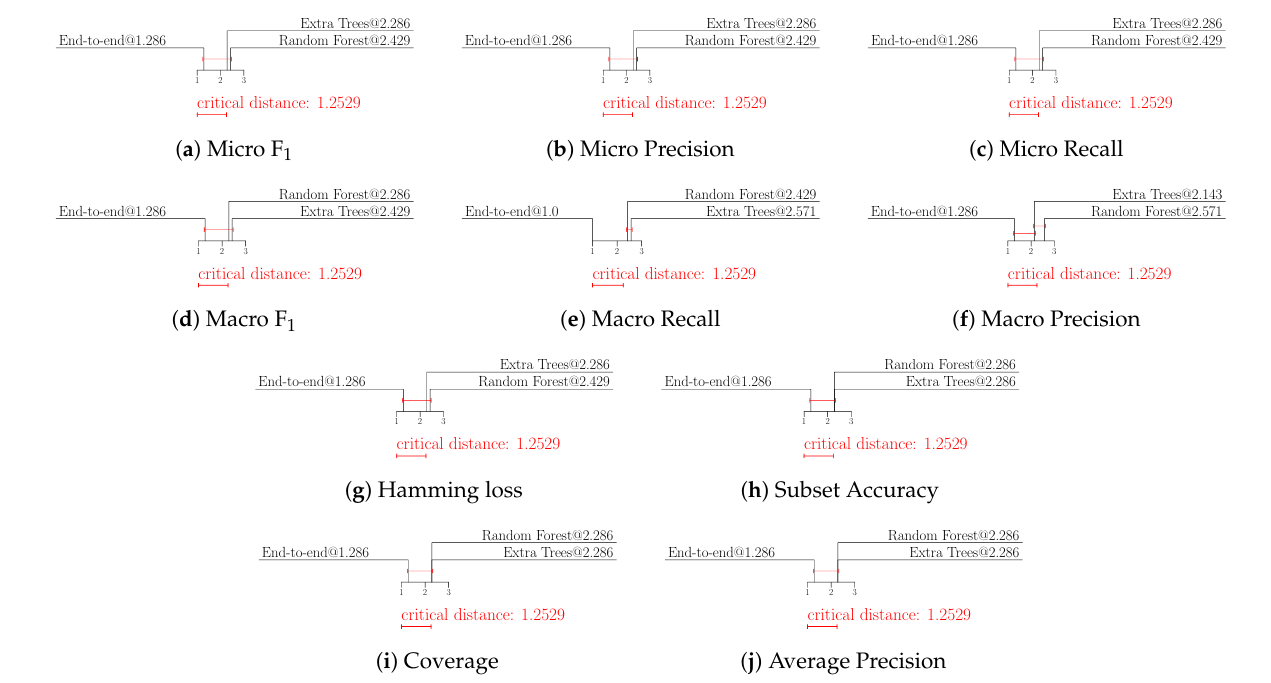
Figure A8. Performance of different learning methods in terms of all MLC evaluation measures for pre-trained features. The results are presented in the form of average rank diagrams at a 0.05 significance level. The best ranking methods are at the left-most side of the diagram. The difference among the methods connected with a red line is not statistically